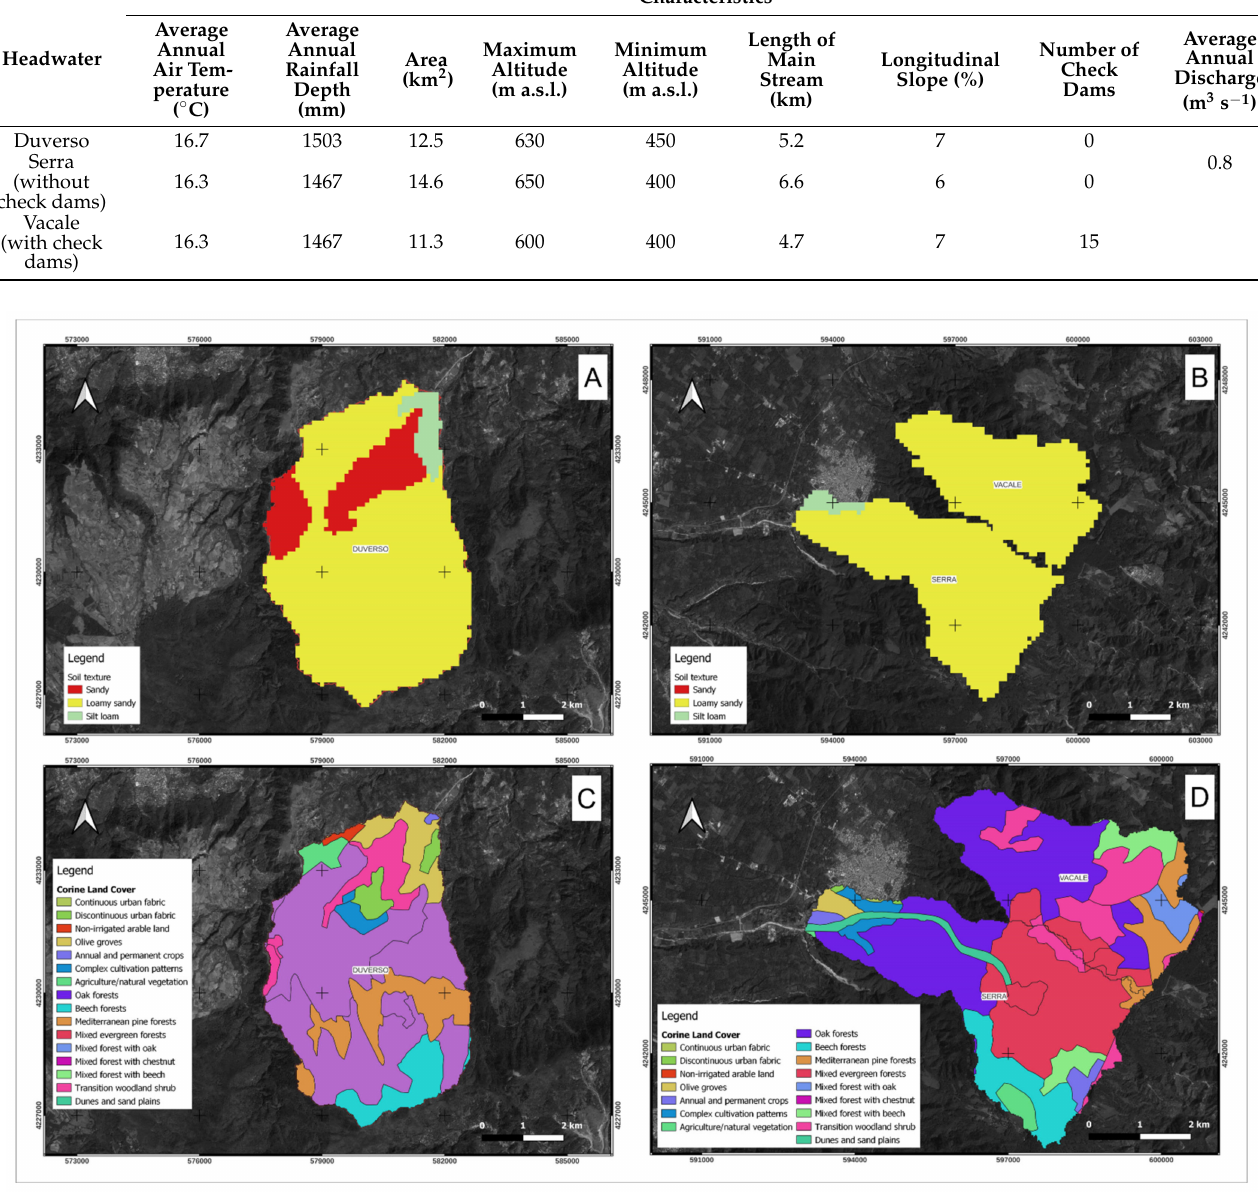
Figure 3. Land use (( A ), Duverso, ( B ), Serra, and Vacale torrents, by photo-interpretation) and soil texture distribution (( C ), Duverso, ( D ), Serra, and Vacale torrents, from the map by ARSSA, 2003) of the investigated subcatchments (Calabria, Southern